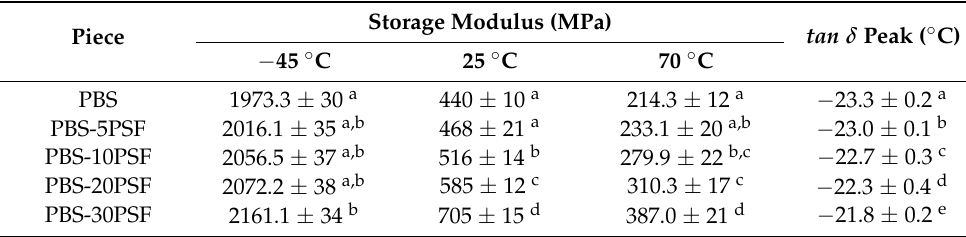
Table 5. Thermomechanical properties of the injection-molded pieces of poly(butylene succinate) (PBS)/pistachio shell flour (PSF) compatibilized with poly(butylene succinate) grafted with maleic anhydride (PBS- g -MAH) in terms of storage modulus measured at − 45, 25, and 70 ◦ C and dynamic damping factor ( tan δ )